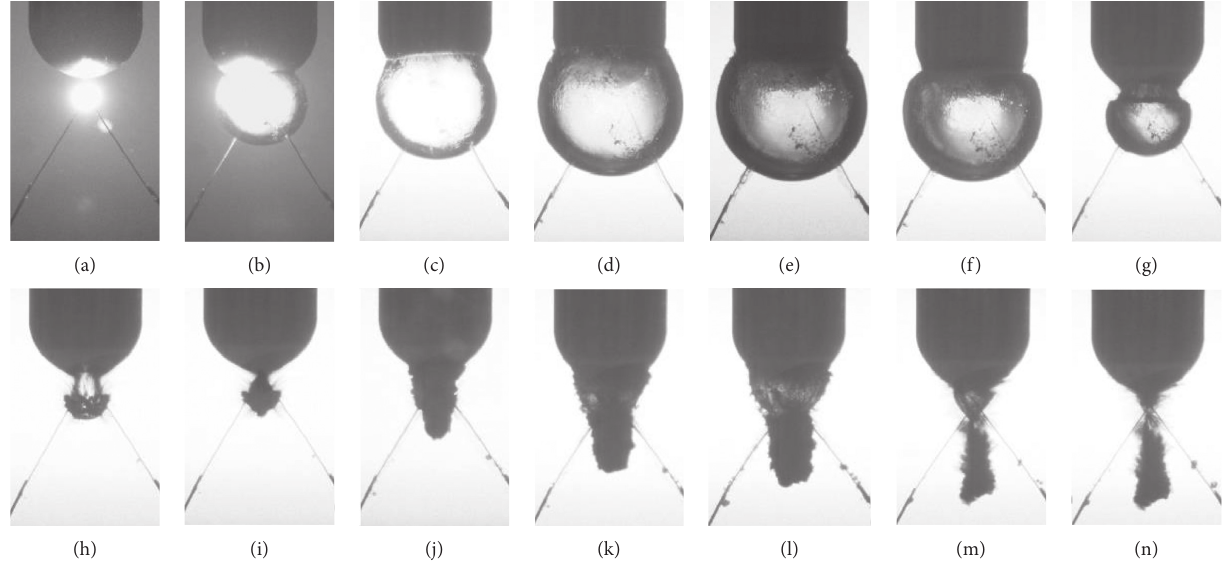
Figure 13: Bubble dynamics under the influence of hemispheric boundary for c � 0.33. (a) 0.000ms. (b) 0.833ms. (c) 1.458ms. (d) 2.583ms. (e) 3.499ms. (f) 4.541. (g) 5.832ms. (h) 5.207ms (i) 5.290 ms. (j) 6.540 ms. (k) 7.040ms. (l) 7.624ms. (m) 8.915ms. (n) 9.082ms.